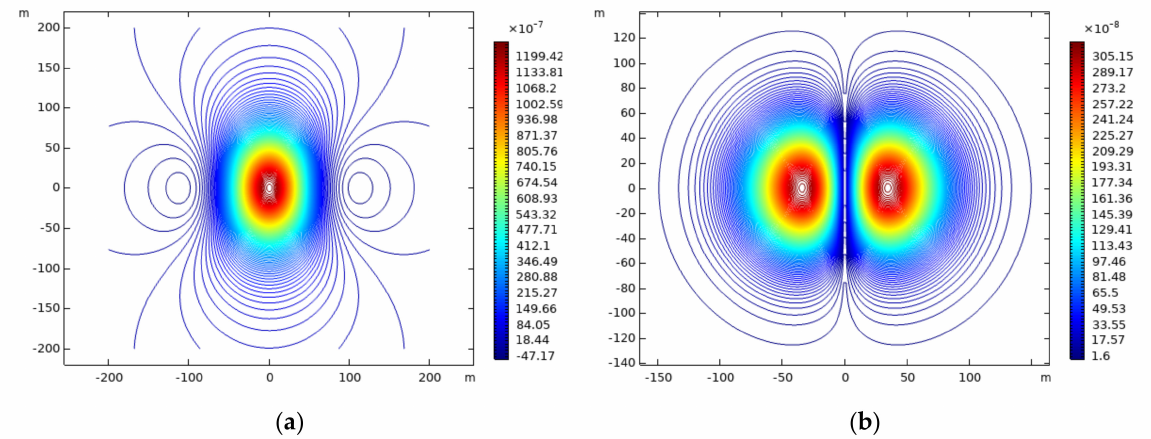
Figure 2. Schematic diagram of transient electromagnetic response in the half space state under the three-dimensional uniform medium. ( a ) Magnetic field distribution (A/m); ( b ) Current induction density (A/m 2 ).